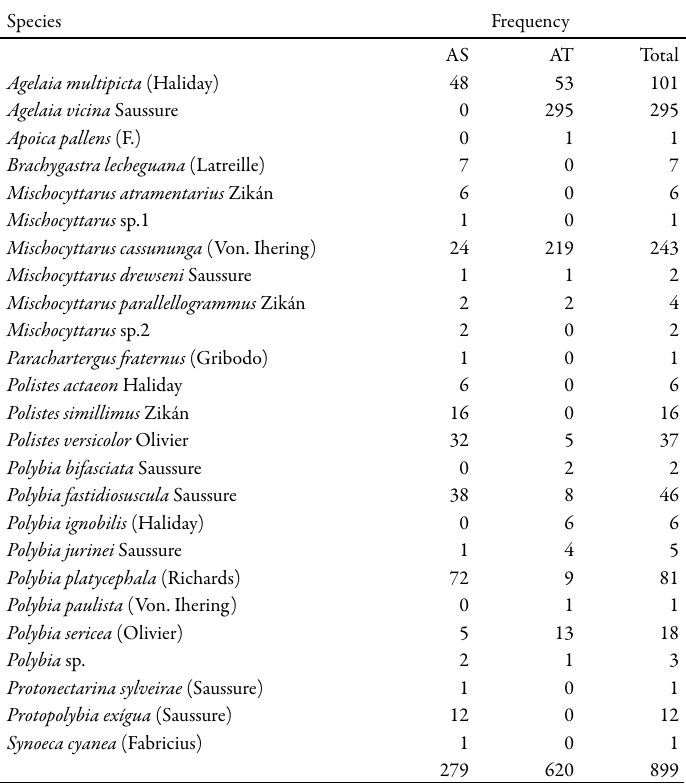
Table 1. Frequency of social wasp species collected in the campus of the “Universidade Federal de Viçosa” in Viçosa, Minas Gerais State, Brazil through active search (AS) and attractive traps (AT) Species Frequency AS AT Total Agelaia multipicta (Haliday) 48 53 101 Agelaia vicina Saussure 0 295